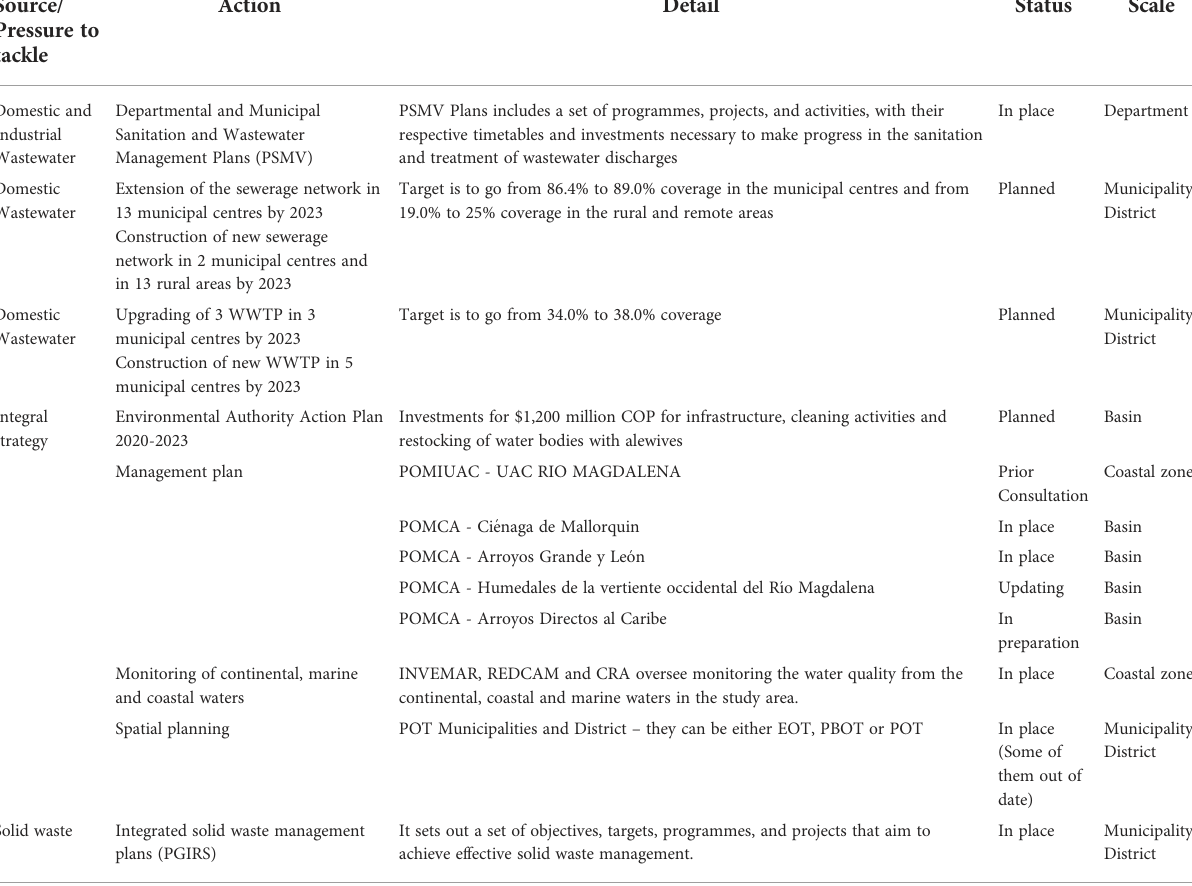
TABLE 7 Example of current Responses